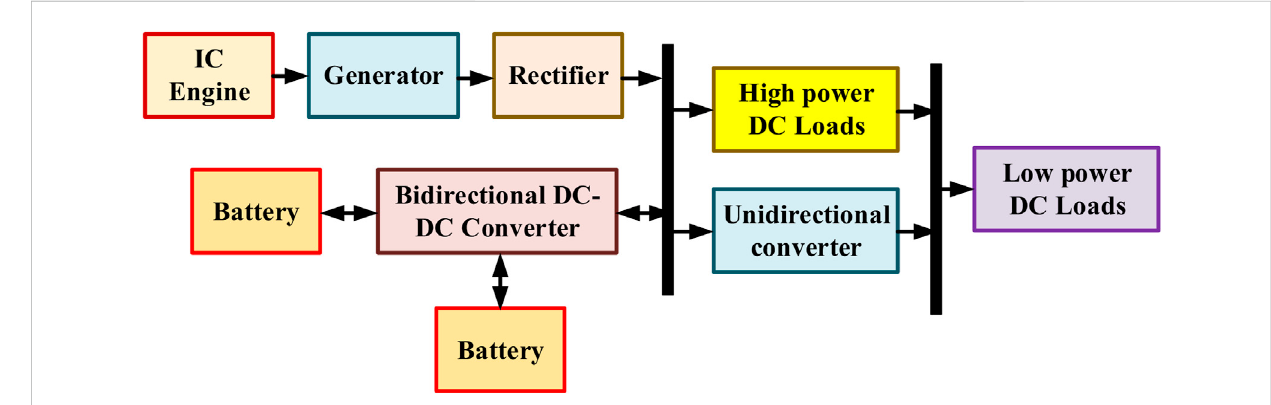
FIGURE 1 Block diagram of battery with the power converter.